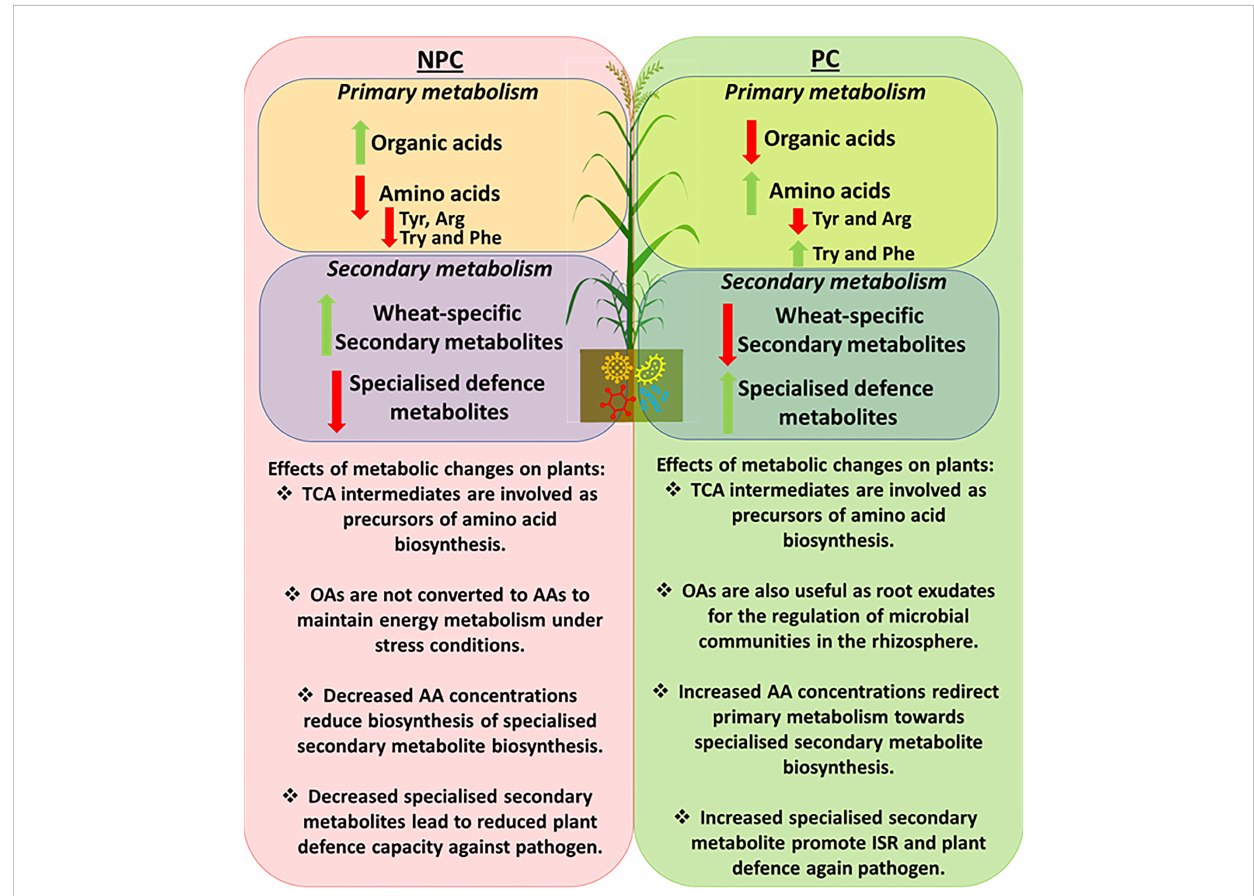
FIGURE 5 Summary diagram of PGPR-induced metabolic changes in plants responding to Pst infection. The left side highlights metabolic changes in the non- prime-challenged (NPC) plants responding to Pst infection. Increased levels of TCA organic acids (OAs) intermediates (malic acid, aconitic acid and citraconic acid) were observed, indicating a low conversion rate to amino acids as an indication of a conserved energy metabolism for plant growth. Ultimately, low OA conversion rate led to reduce amino acids (AAs) concentrations and the subsequent reductions in specialised secondary defence metabolites. An opposite effect was observed in primed challenged (PC) plants in which PGPR priming induced the accumulation of specialised secondary defence metabolites. This phenomenon may have occurred due to the rapid conversion of precursor amino acids towards secondary metabolites biosynthesis and thus induced systemic resistance against the invading